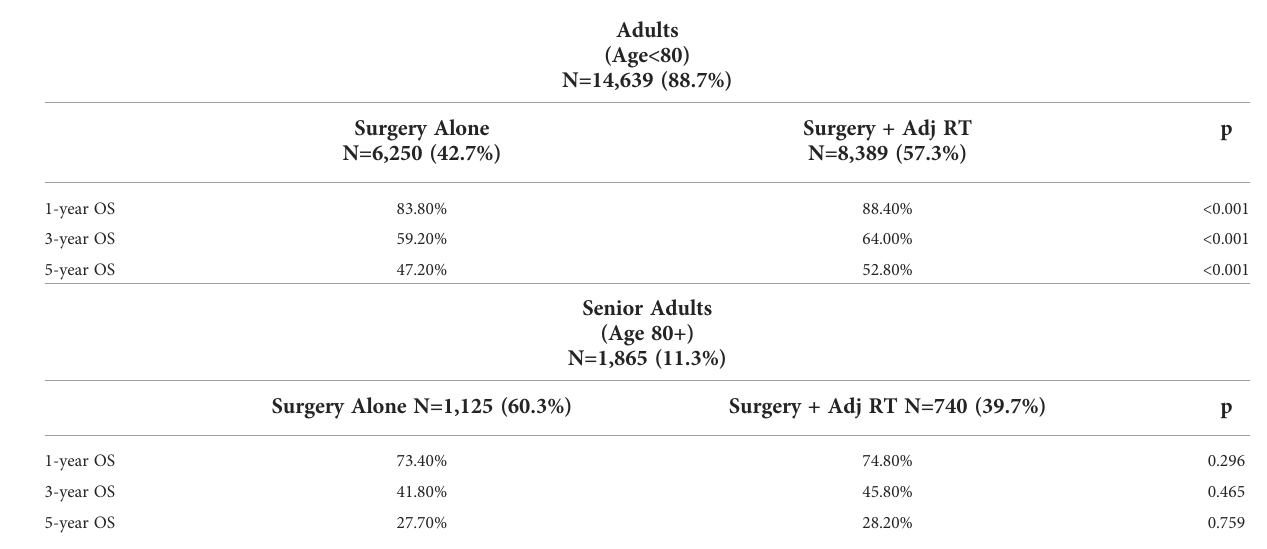
TABLE 3 Kaplan Meier estimates of OS by age cohort and treatment group.